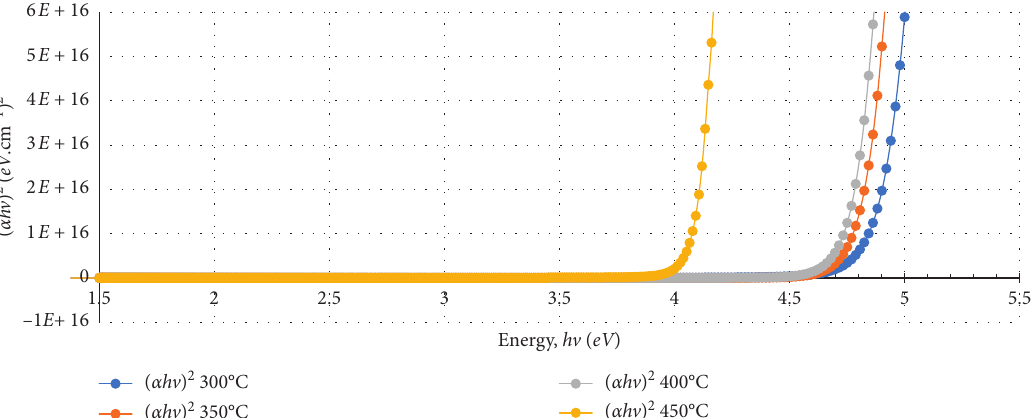
Figure 11: The energy bandgaps of SnO